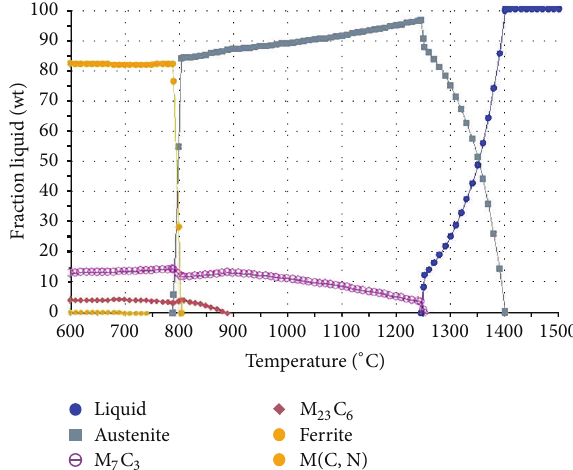
Figure 5: Phase equilibrium diagram of AISI D2 tool steel obtained from JMatPro